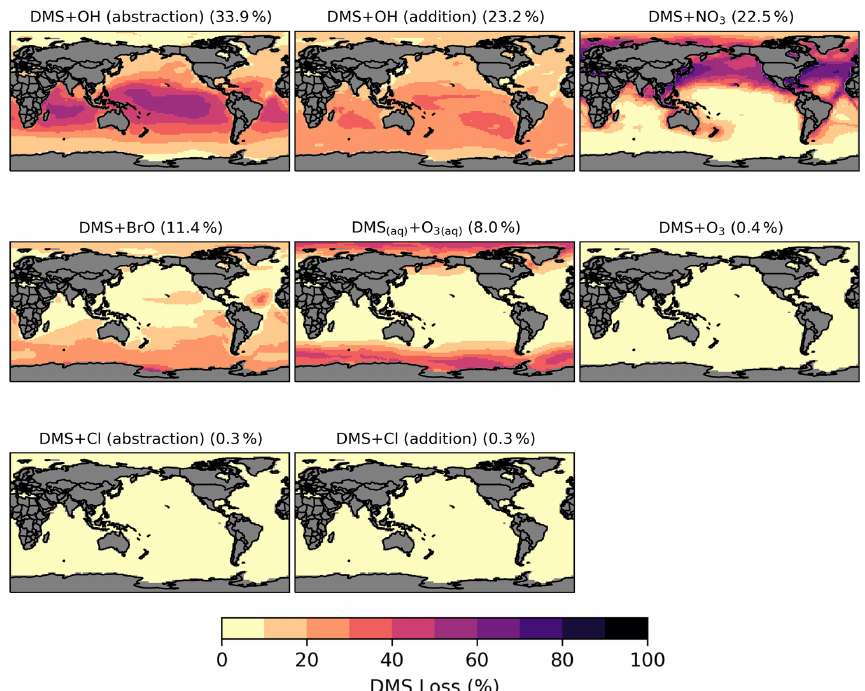
Figure 3. Spatial distribution of the fractional DMS oxidation (percent) from [MOD_2000] through DMS + OH (abstraction), DMS + OH (addition), DMS + NO 3 , DMS + BrO, DMS (aq) + O 3(aq) , DMS + O 3 , DMS + Cl (abstraction), and DMS + Cl (addition). Percentages in parentheses denote contribution to global chemical loss. Subplots are arranged in descending order of their annual total oxidation